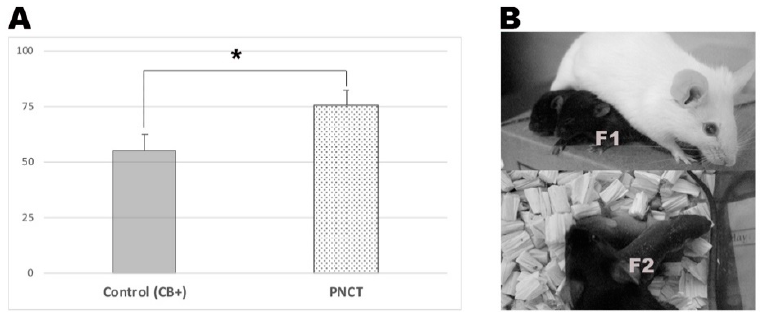
Figure 2. In vitro development of PNCT embryos and PCNT-derived pups. ( A ) Figure depicts the blastocyst rates of PNCT embryos and control embryos. Control 2PN embryos were exposed to a 10 μ g/mL concentration of CB for 30 min, referred to as control (CB+). Asterisk indicates statistical significance ( p < 0.05). ( B ) Upper panel depicts F1 pups derived by PNCT. Lower panel shows F2 pups generated via natural mating of F1.